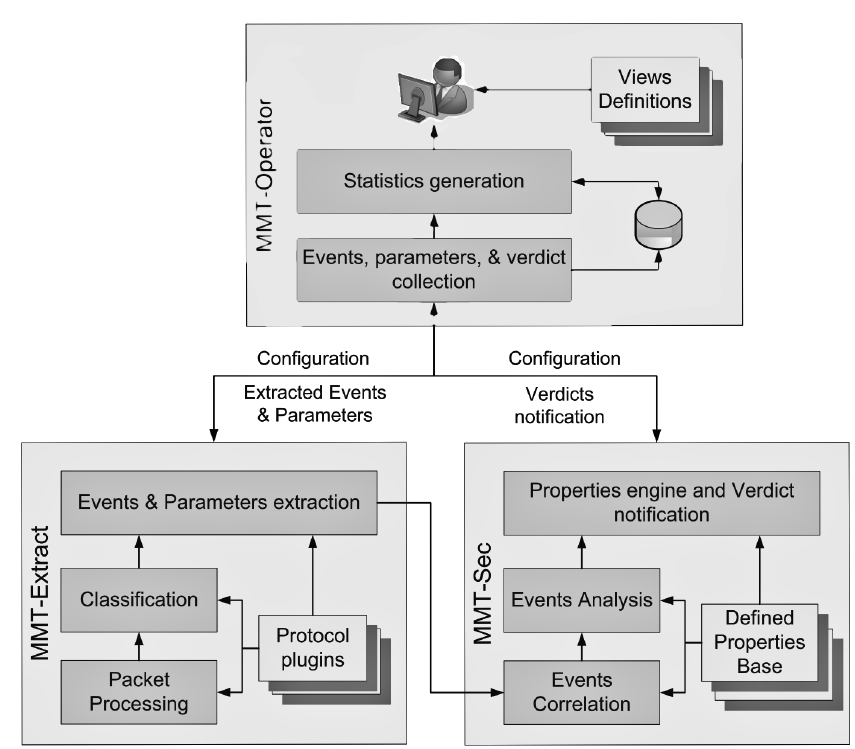
Figure 7. Component Architecture of Montimage Monitoring